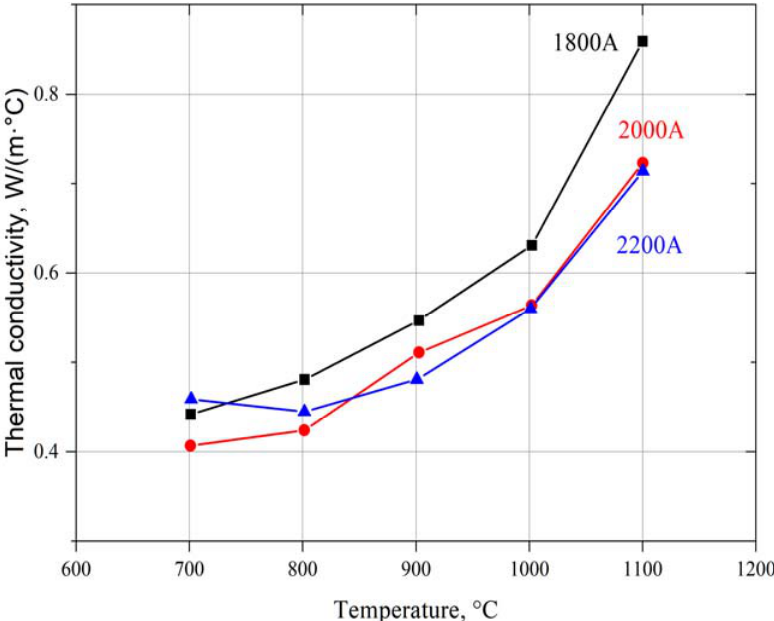
Figure 6. Thermal conductivity of synthetized Yb 2 Zr 2 O 7 in the reactive PS-PVD process using different power currents in the temperature range 700–1100 °C.